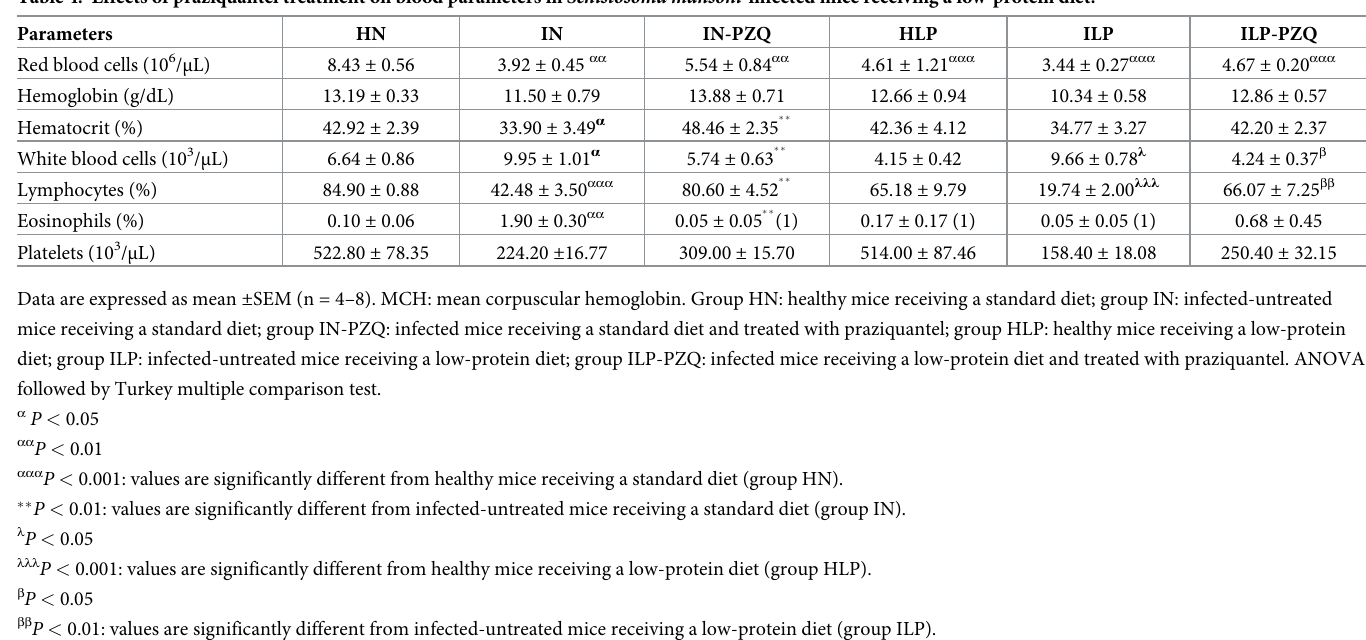
(HN). In the IN and ILP groups of mice, malondialdehyde (MDA) concentration significantly increased. In contrast, superoxide dismutase (SOD) and catalase (CAT) activities and reduced glutathione (GSH) concentration significantly decreased as compared to their respective con- trols. The nitrites level decreased only in IN group compared to the HN group. Praziquantel treatment ameliorated the MDA concentration by reducing it by 64.73% in IN-PZQ as com- pared to IN ( P < 0.001) and 25.72% in ILP-PZQ as compared to ILP ( P < 0.05). Despite this significant reduction, the MDA concentration of ILP-PZQ mice was 69.56% higher than that of IN-PZQ mice ( P < 0.05). In both standard and low-protein diet-feed infected mice, treatment with praziquantel restores the SOD and CAT activities. We recorded 49.35% and 63.96% increase of SOD activ- ity and 33.29% and 57.22% increases of catalase activity in IN-PZQ and ILP-PZQ groups of mice, respectively, when compared to their infected-untreated controls groups. However, pra- ziquantel treatment did not reverse the reduced concentration of GSH in IN-PZQ mice. On the contrary, GSH concentration significantly increased by 47.34% in ILP-PZQ mice com- pared to ILP mice ( P < 0.001). Furthermore, PZQ treatment did not restore the nitrite levels, whatever the type of diet, and it was significantly low in ILP-PZQ mice compared to ILP mice ( P < 0.05), as well as to IN-PZQ mice ( P < 0.05). PZQ treatment improved the MDA concen-